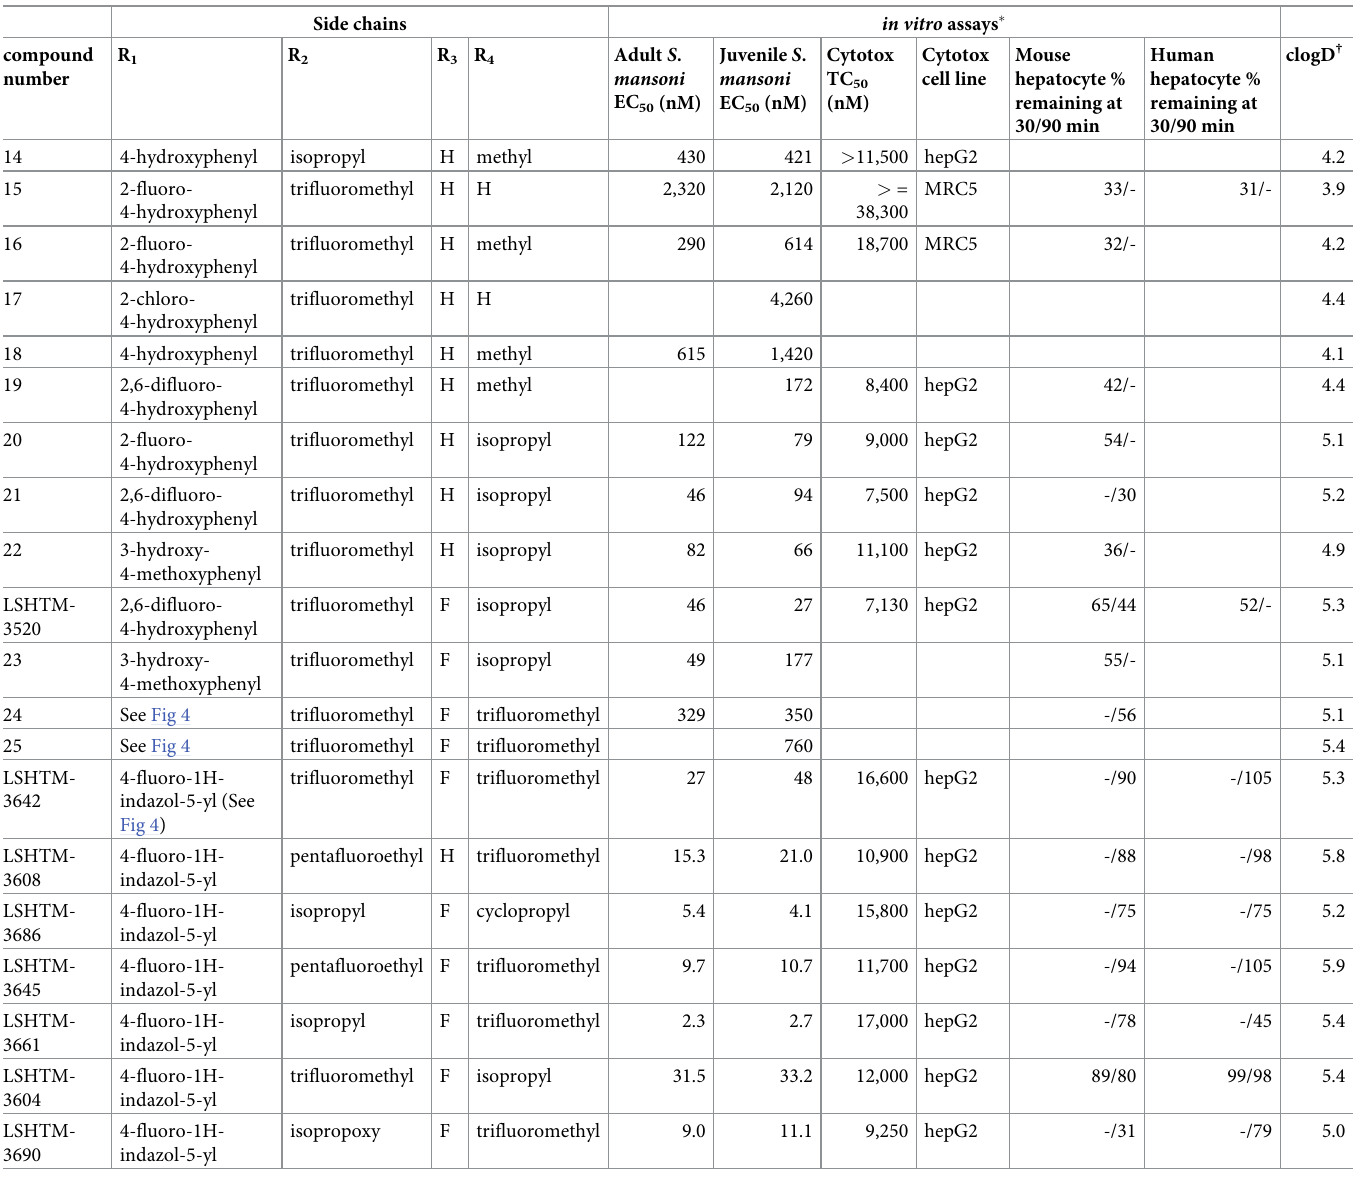
Table 2. Structure activity relationship of more potent and stable